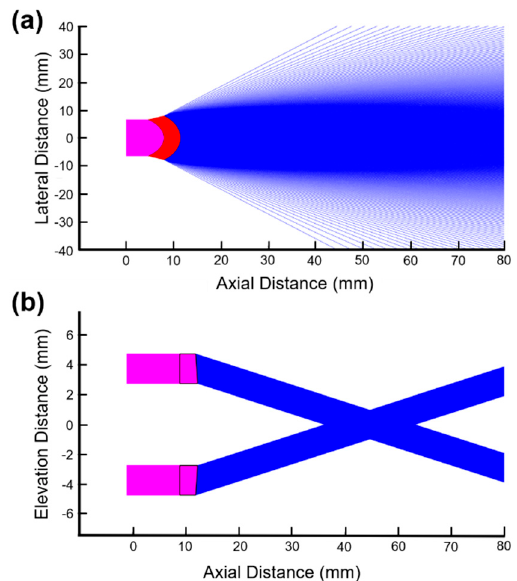
Figure A2. Results of numerical simulation based on the equations derived by using the ray tracing method: ( a ) concave/convex-shaped lens in the lateral-axial plane and ( b ) planar/oblique-shaped lens in the elevation-axial plane. Note that the magenta lines are collimated incoming rays, and the red lines are the refracted rays.